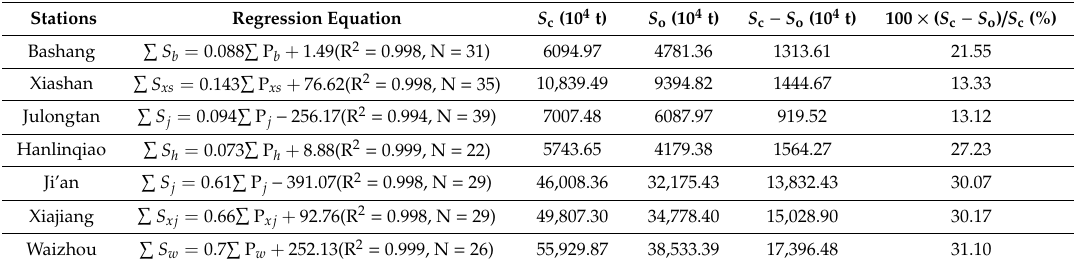
Table 4. The observed and calculated cumulative sediment discharge at hydrological stations in the Ganjiang River basin.